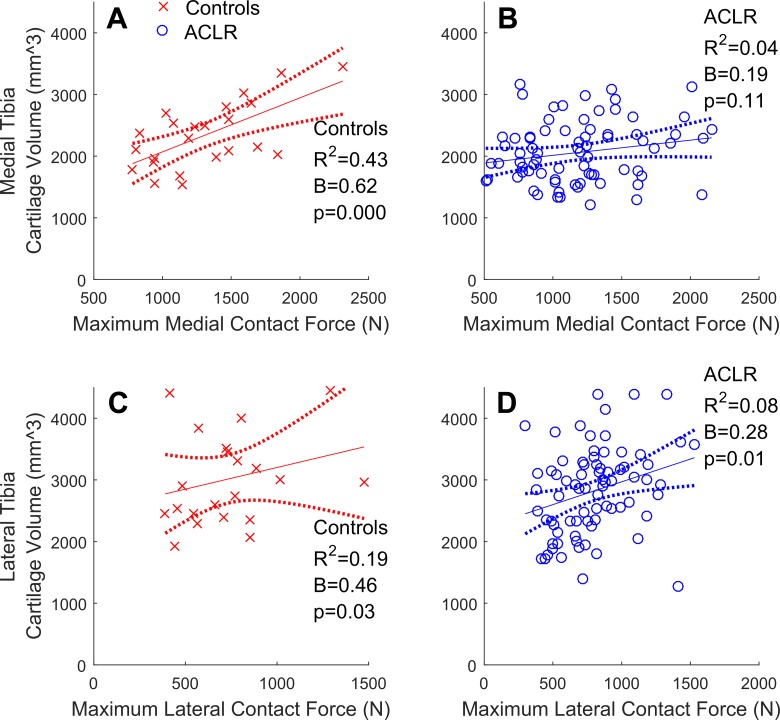
Tibial articular cartilage volumes (mm3) regressed onto maximum walking tibiofemoral contact forces (N) with the 95% confidence intervals (dotted lines) for the control (cross-hairs) and overall cohort of ACLR knees (circles). (A and B) Medial compartment; (C and D) lateral compartment. ACLR, anterior cruciate ligament reconstruction.